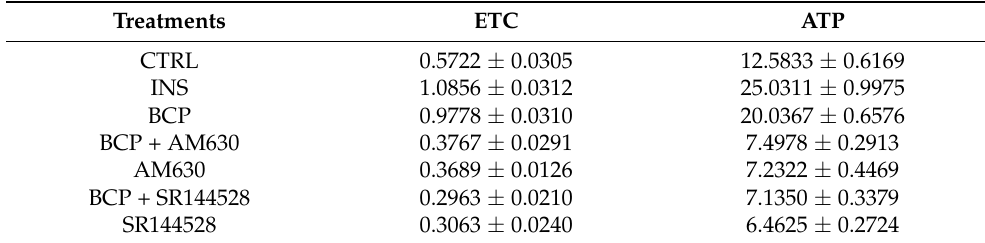
Table 3. BCP effects on mitochondrial